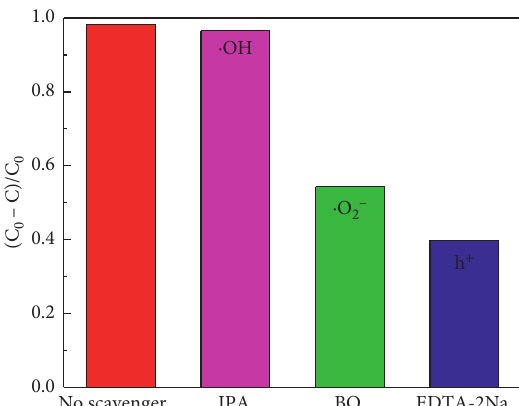
− , and EDTA-2Na for 2